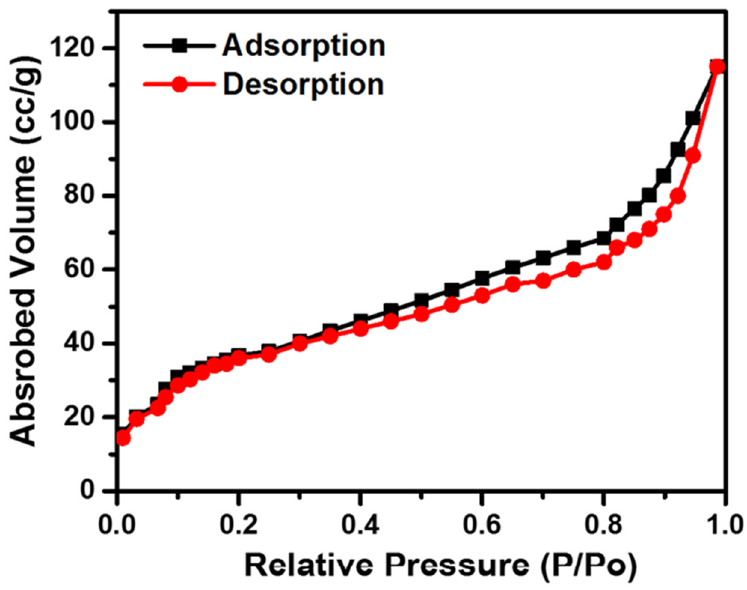
Figure 9. Nitrogen Adsorption–desorption isotherm curve of PA6 nanofiber membrane .